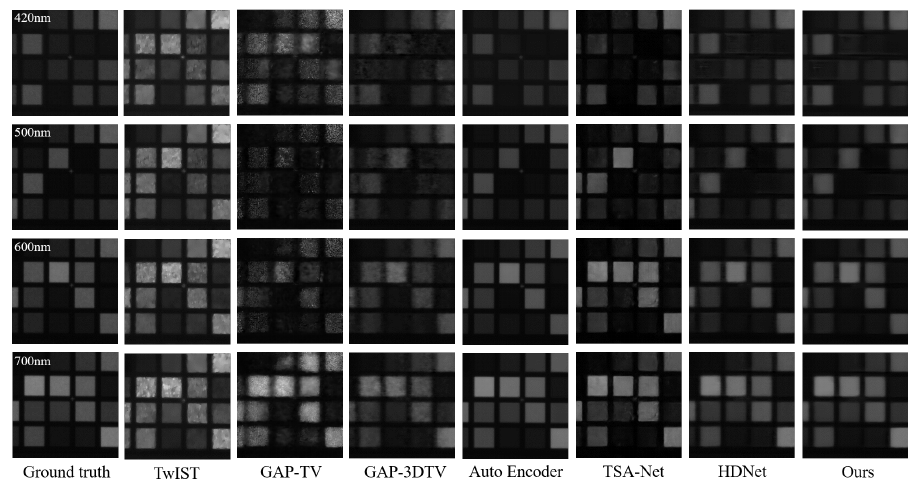
Figure 6. Reconstructed spectral images of stuf fed toys with a size of 512 × 512 from the CAVE dataset. We show the reconstructed result of four bands (wavelength: 420, 500, 600, and 700 nm) by different algorithms.